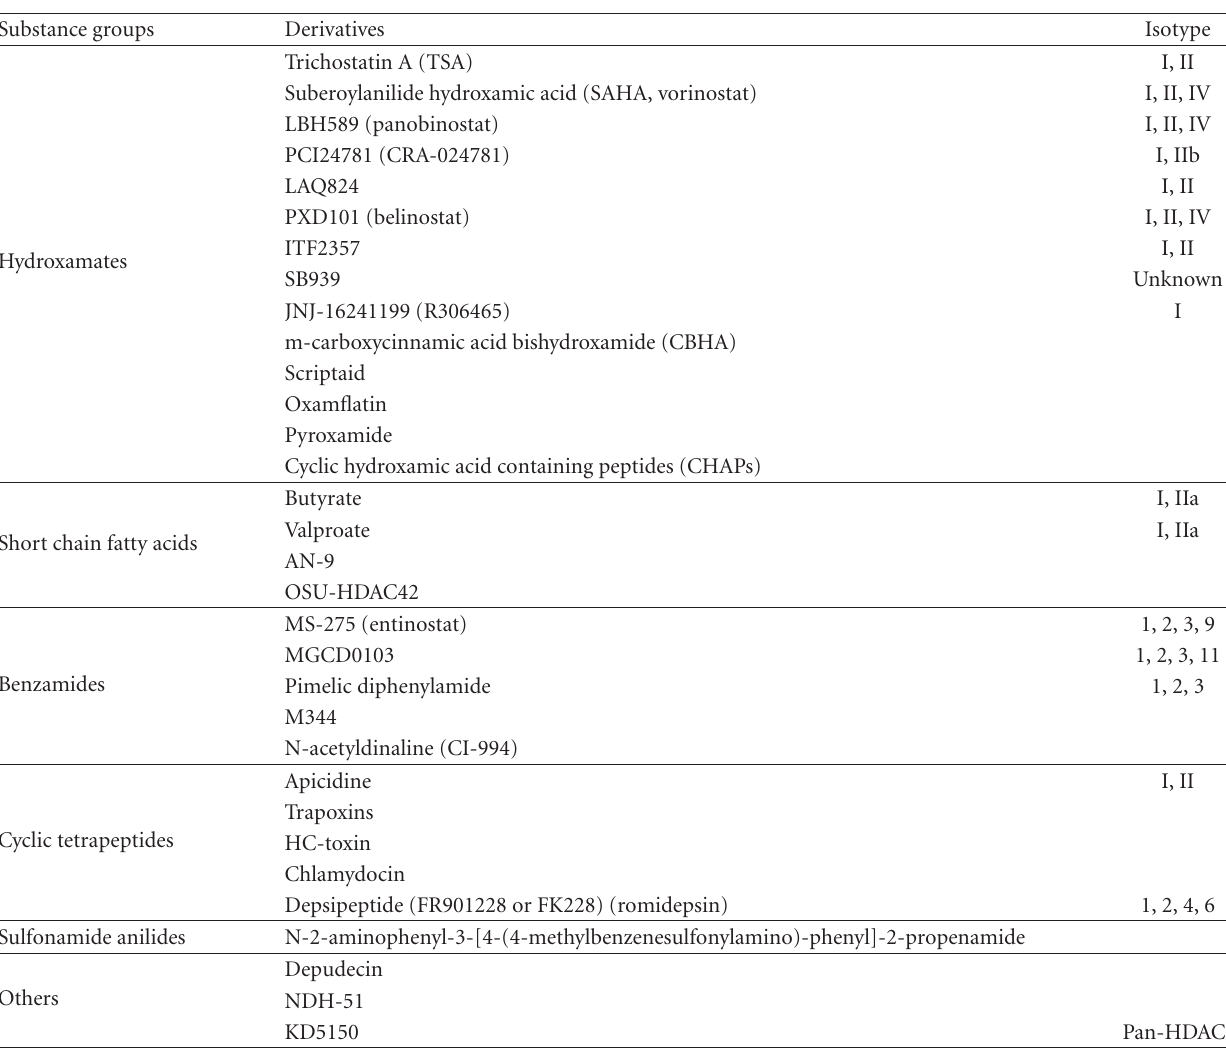
Table 1: Overview of frequently used histone deacetylase inhibitors that are available for clinical and research purposes. Substance